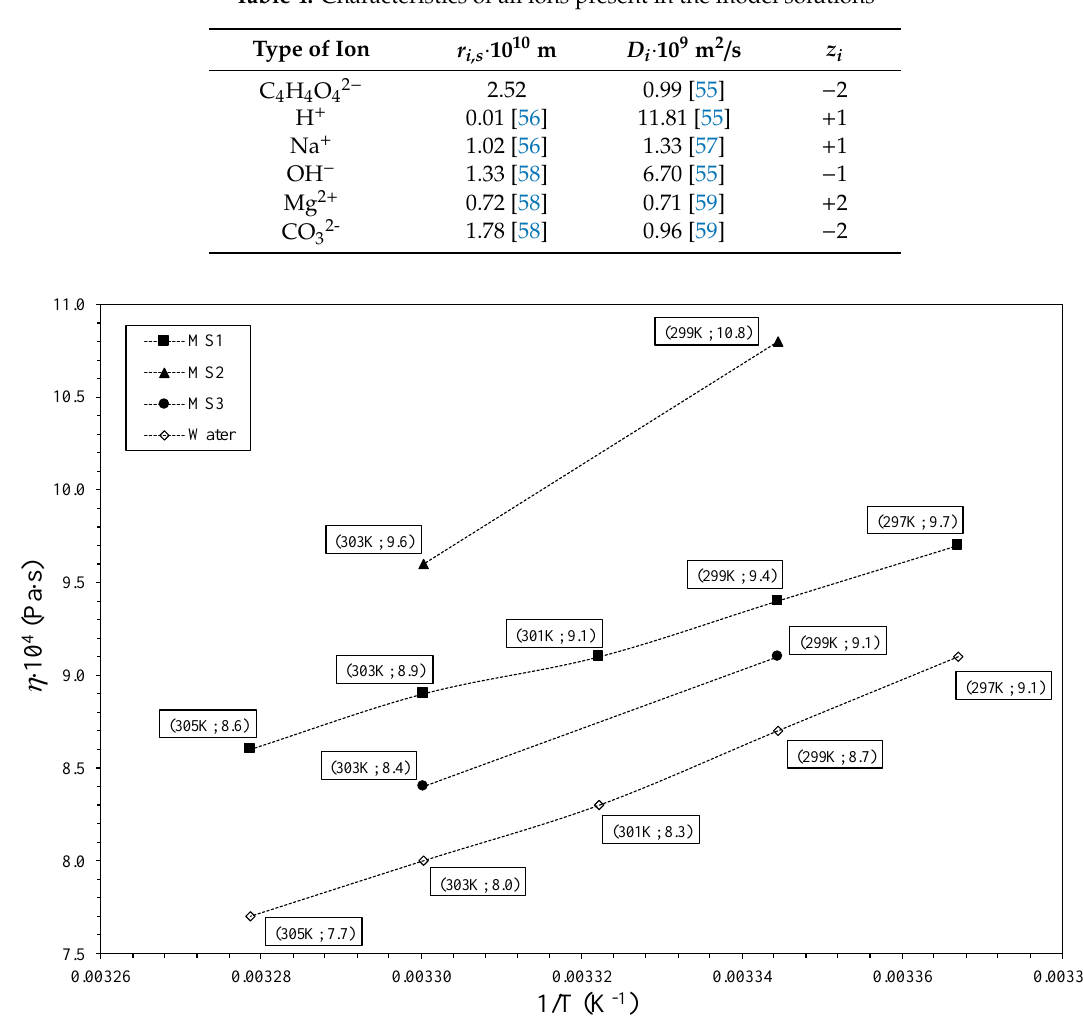
Table 4. Characteristics of all ions present in the model solutions